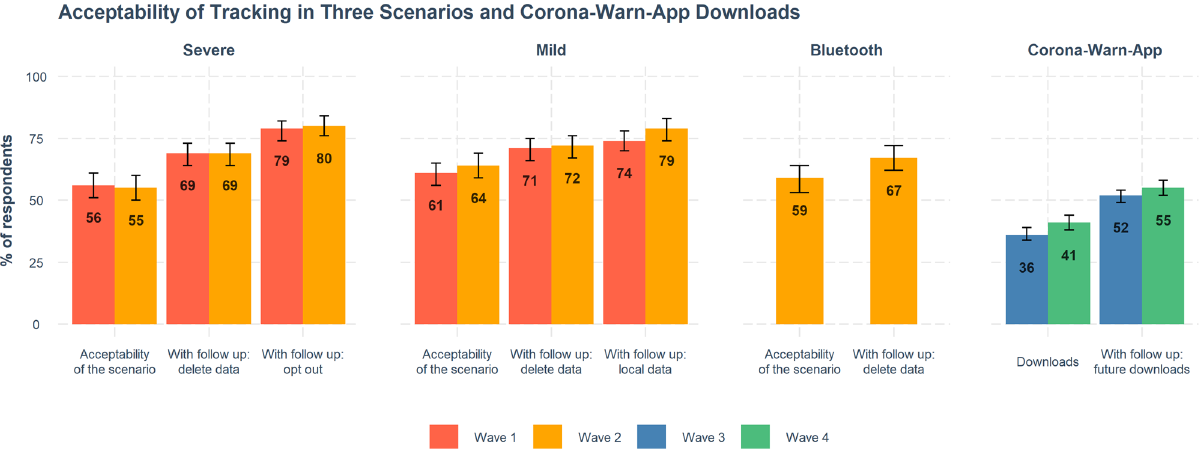
Figure 5. Acceptability of hypothetical tracking technologies and numbers of Corona-Warn-App downloads. For the hypothetical scenarios, the first column displays baseline acceptability ratings; the other two columns display acceptability under varying conditions: with the requirement that all data be deleted and tracking stopped after 6 months; with an “opt out” option (severe scenario); and with data being stored locally on